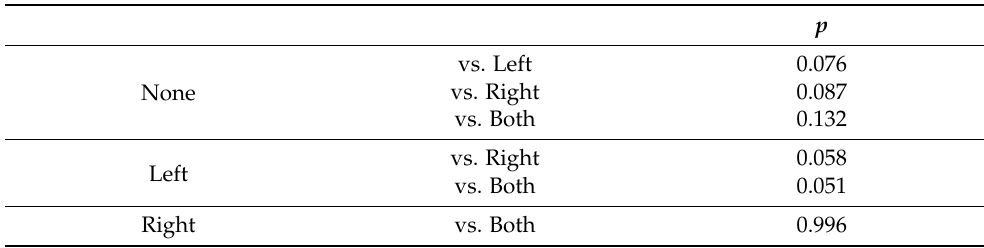
Table 3. Subgroup analysis of CFS dominance divided by total counts of CFS ≥ grade 2 on left and right sides for arm pain